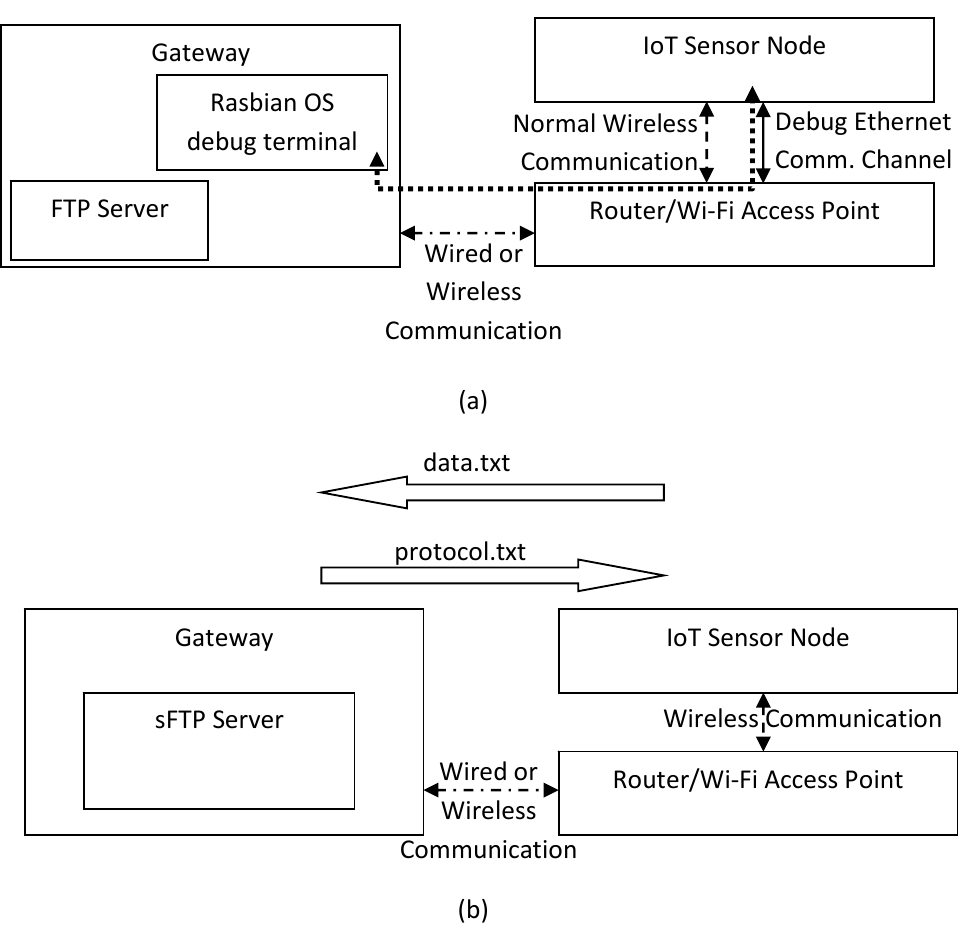
Figure 3. Sensor Controller and Gateway configuration in ( a ) debug and ( b ) real time mode.